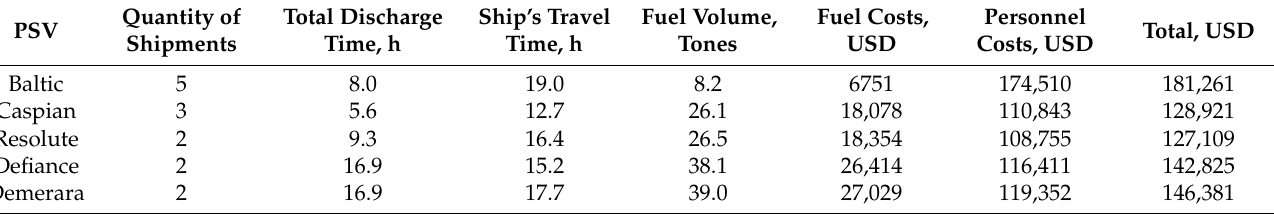
Table 5. Calculation of offshore transportation